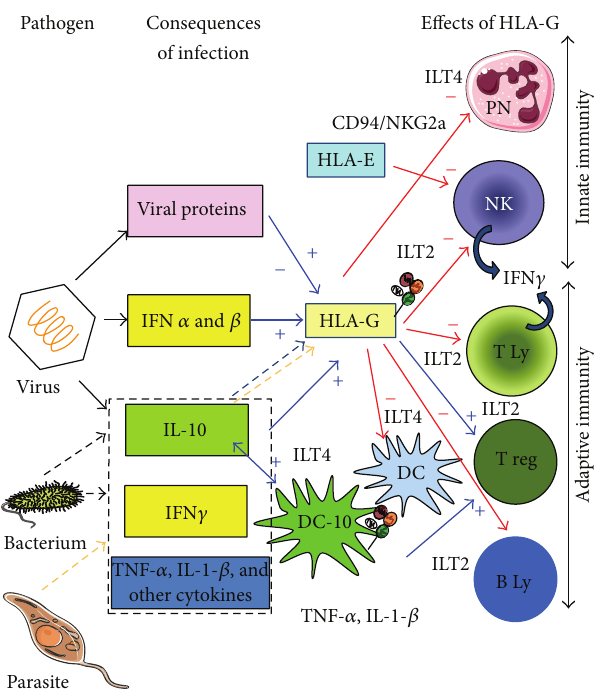
Figure 1: Causes and consequences of HLA-G modulation in infec- tious diseases. Positive and negative effects of HLA-G are shown in blue and red, respectively. Parasites, bacteria, or viruses induce the secretion of various cytokines, including IL-10 and interferon (- 𝛾 for bacterium and IFN- 𝛼 and - 𝛽 for virus). These cytokines upregulate the expression or secretion of HLA-G. In addition, IL- 10 induces IL-10-producing human dendritic cells (DCs), termed DC-10, expressing HLA-G and ILT4. HLA-G induces tolerogenic DC in addition to DC-10 and regulatory cells via direct interaction with ILT2 and/or ILT4. HLA-G, through direct interaction with ILT2, inhibits the function of T and NK cells and B cells, whereas it inhibits the function of granulocytes and myeloid DC via direct interaction with ILT4. Indirect effects of HLA-G are mediated by the induction of HLA-E cell surface expression, which inhibits CD94/NKG2aonNKandTcells.TheconsequenceofHLA-Gaction is a downregulation of innate and adaptive